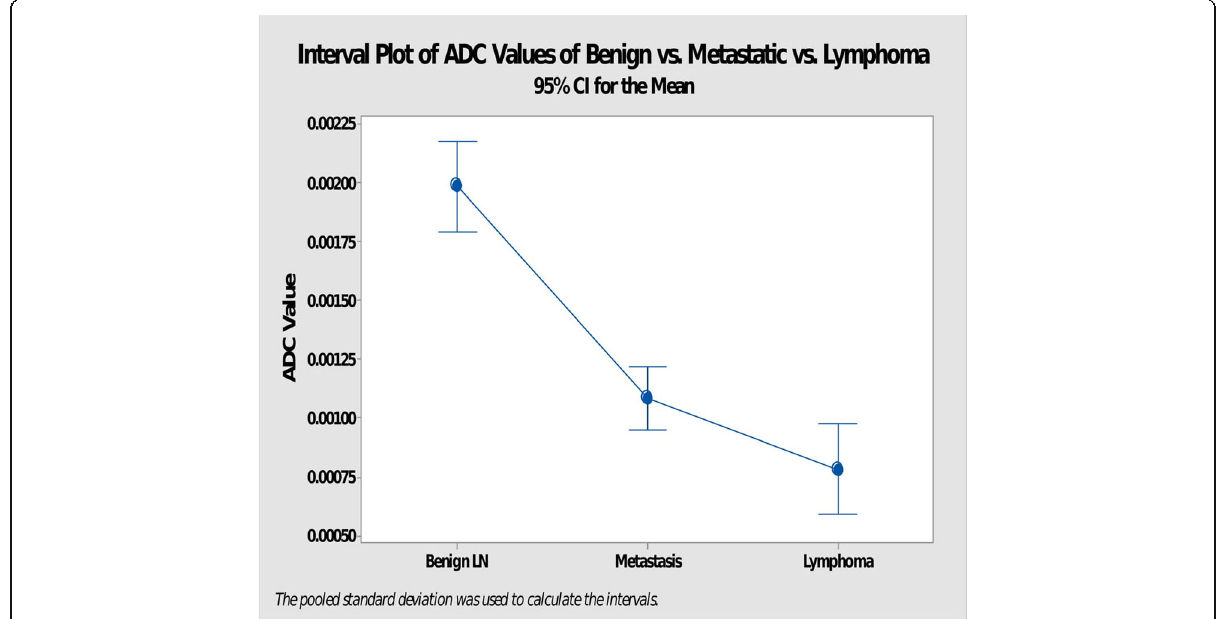
Fig. 4 Interval plot of ADC values of benign LN, metastatic LN, and lymphomatous